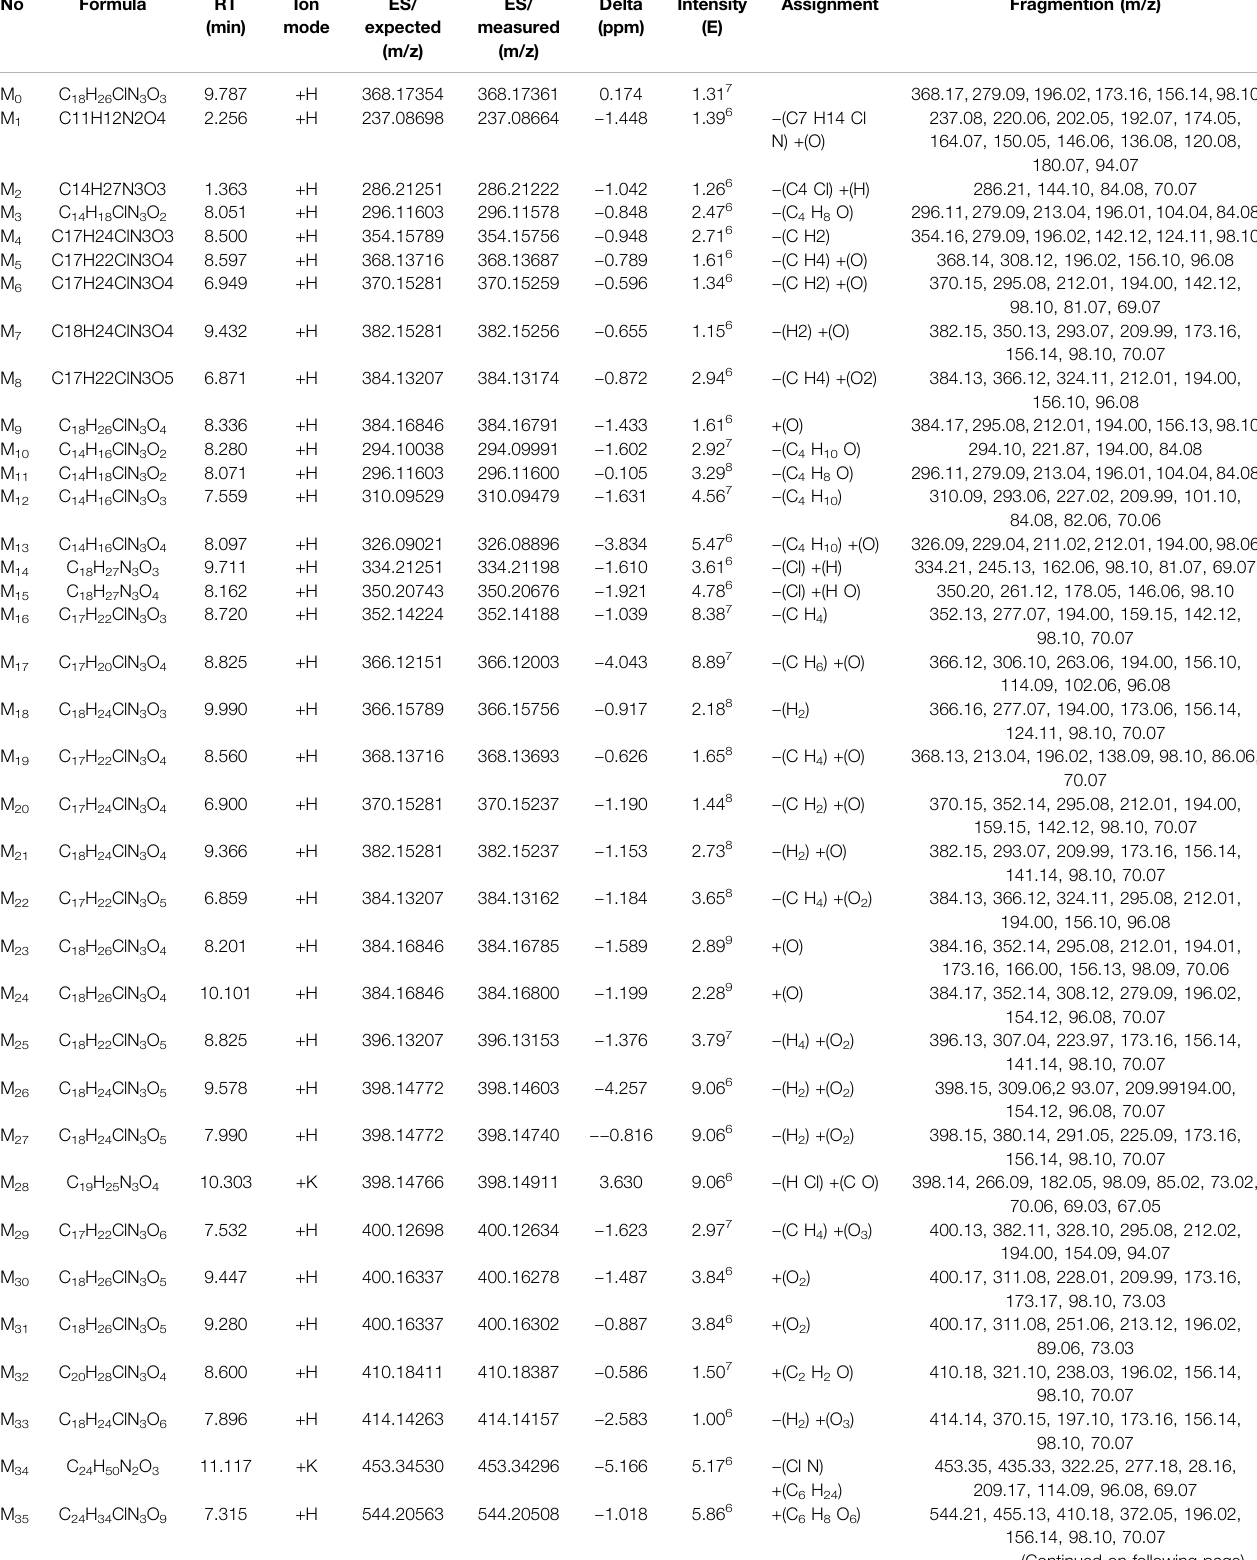
TABLE 1 | All information of 47 metabolites of prucalopride detected and annotated by UHPLC-Q-Orbitrap